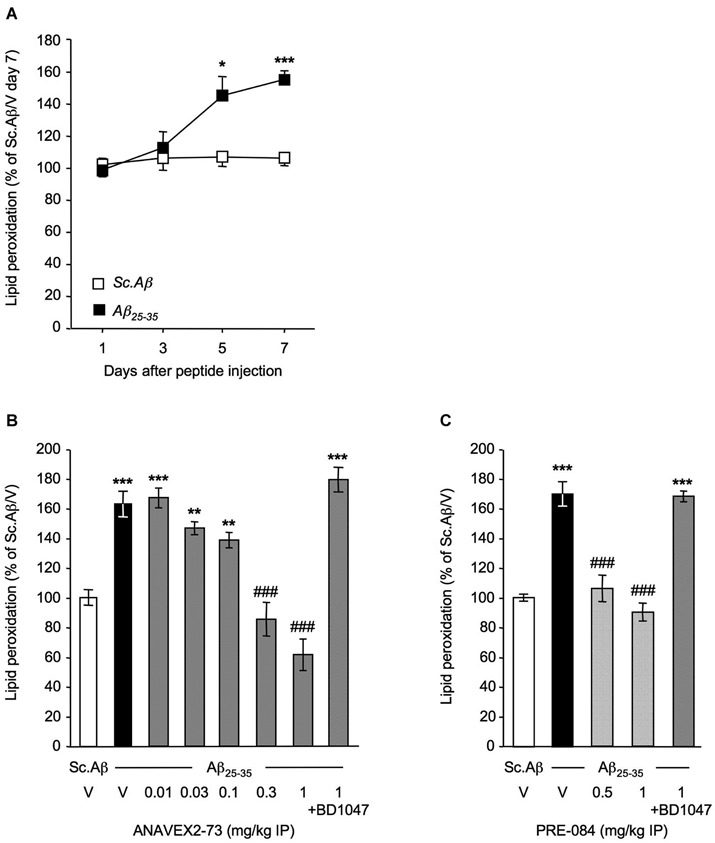
ANAVEX2-73 and PRE-084 prevented oxidative stress in Aβ25–35-treated mice. Mice were administered ICV with Sc. Aβ or Aβ25–35 peptide (9 nmol) and sacrificed after 1, 3, 5 or 7 days for lipid peroxidation measures (A). n = 6 per group, *p < 0.05, ***p < 0.001 vs. the (Sc. Aβ + V)-treated group at the same timepoint; t-test. Mice were then administered IP with (B) ANAVEX2-73 (0.01–1 mg/kg) or (C) PRE-084 (0.5–1 mg/kg) 20 min before Aβ25–35 (9 nmol). In two groups, BD1047 (10 mg/kg) was administered simultaneously with the highest dose of each agonist. Mice were sacrificed after 7 days for lipid peroxidation measures. One-way ANOVA: F(7,70) = 22.5, p < 0.0001, n = 6–14 per group in (B); F(4,69) = 31.9, p < 0.0001, n = 6–22 in (C). **p < 0.01, ***p < 0.001 vs. the (Sc. Aβ+V)-treated group; ###p < 0.001 vs. the (Aβ25–35+V)-treated group; Dunnett’s test.